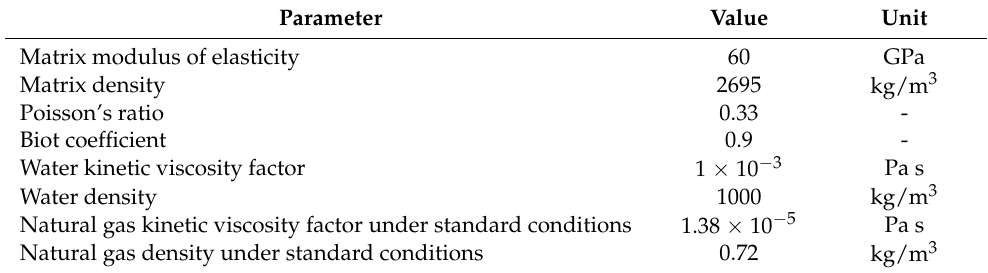
Table 4. Numerical model